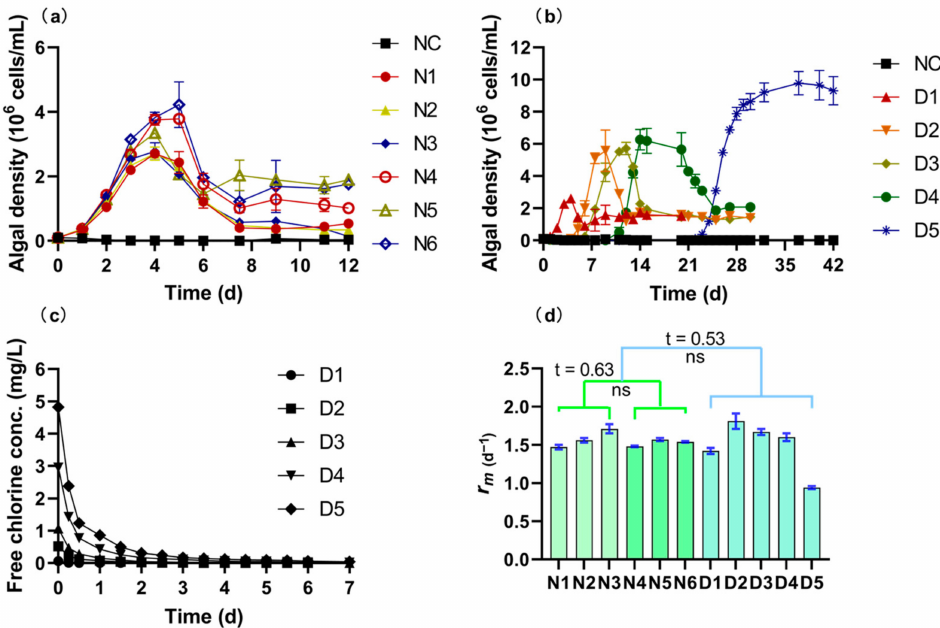
Figure 1. Characteristics of algal growth and chlorine decay. ( a ) Algal density in non-chlorinated groups, ( b ) algal density in chlorinated groups, ( c ) concentrations of free chlorine, and ( d ) the specific growth rate ( r m ) of algae, the "ns" indicates no significant change.